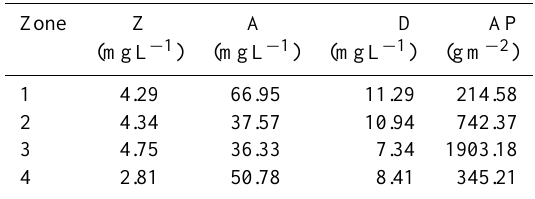
Table 8. Water ecological indices of different water area zones.